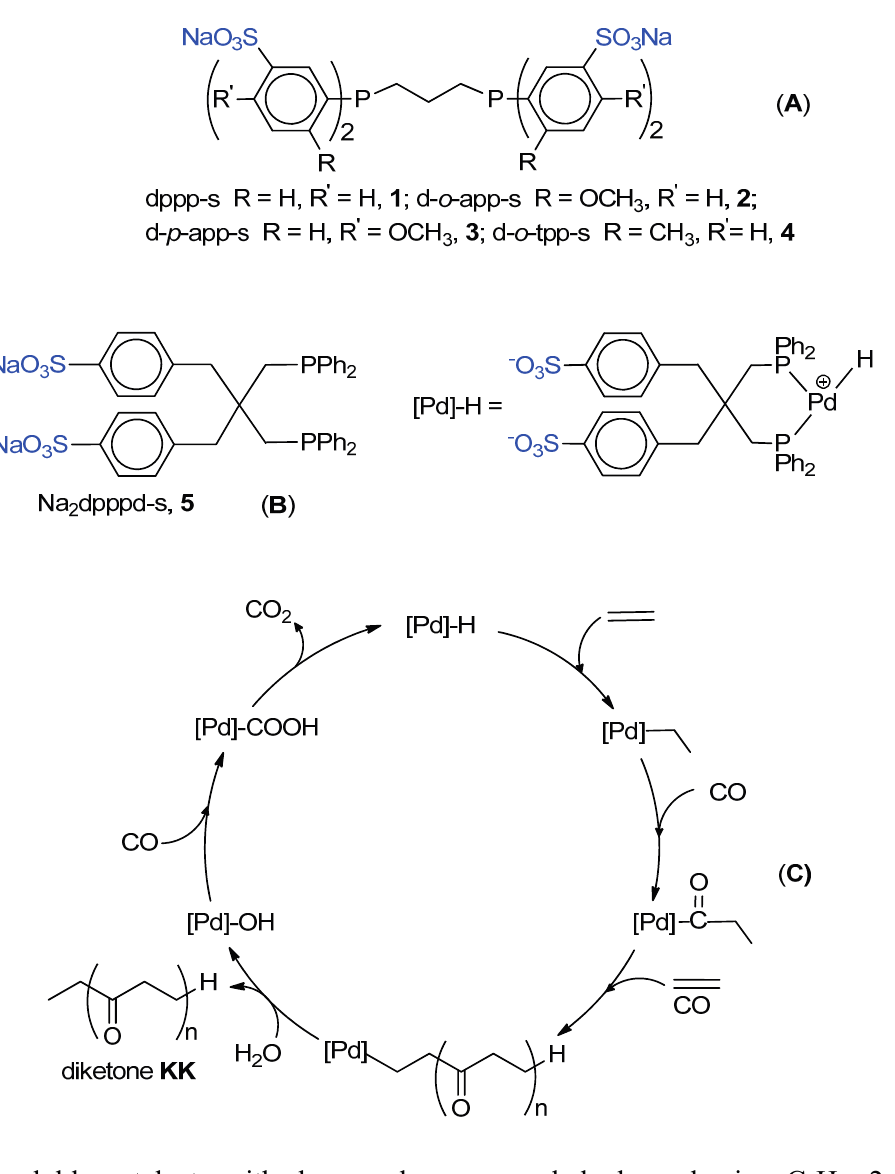
Figure 6. Sulfonate ligands for water-soluble catalysts ( A ); catalytic cycle for